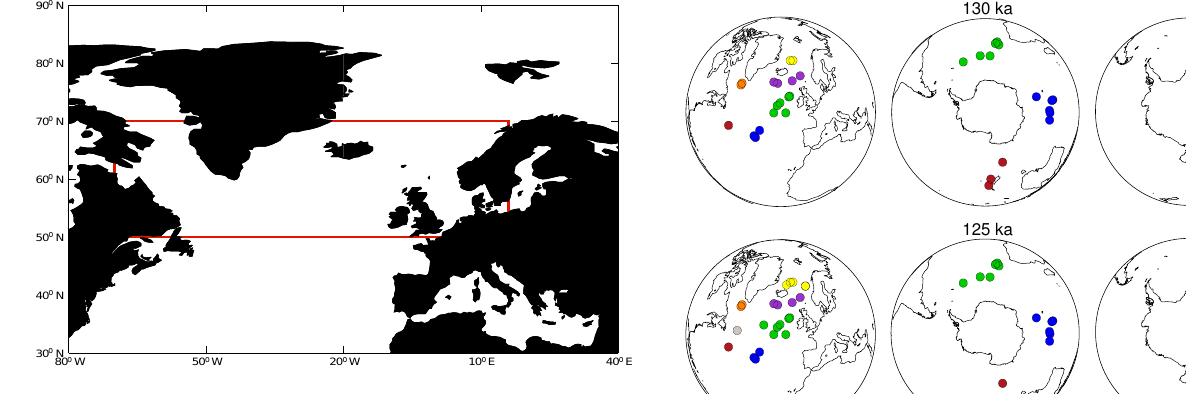
Figure 3. The North Atlantic region for freshwater input denoted by the red box (50–70 ◦ N). Note that the freshwater amount is evenly distributed within this region. Figure 4. Locations of 130 and 125ka data-based time slice data from Capron et al. (2014). The colours denote the groups of data used in Method 2 (Eq. 2) to calculate the RMSE for each